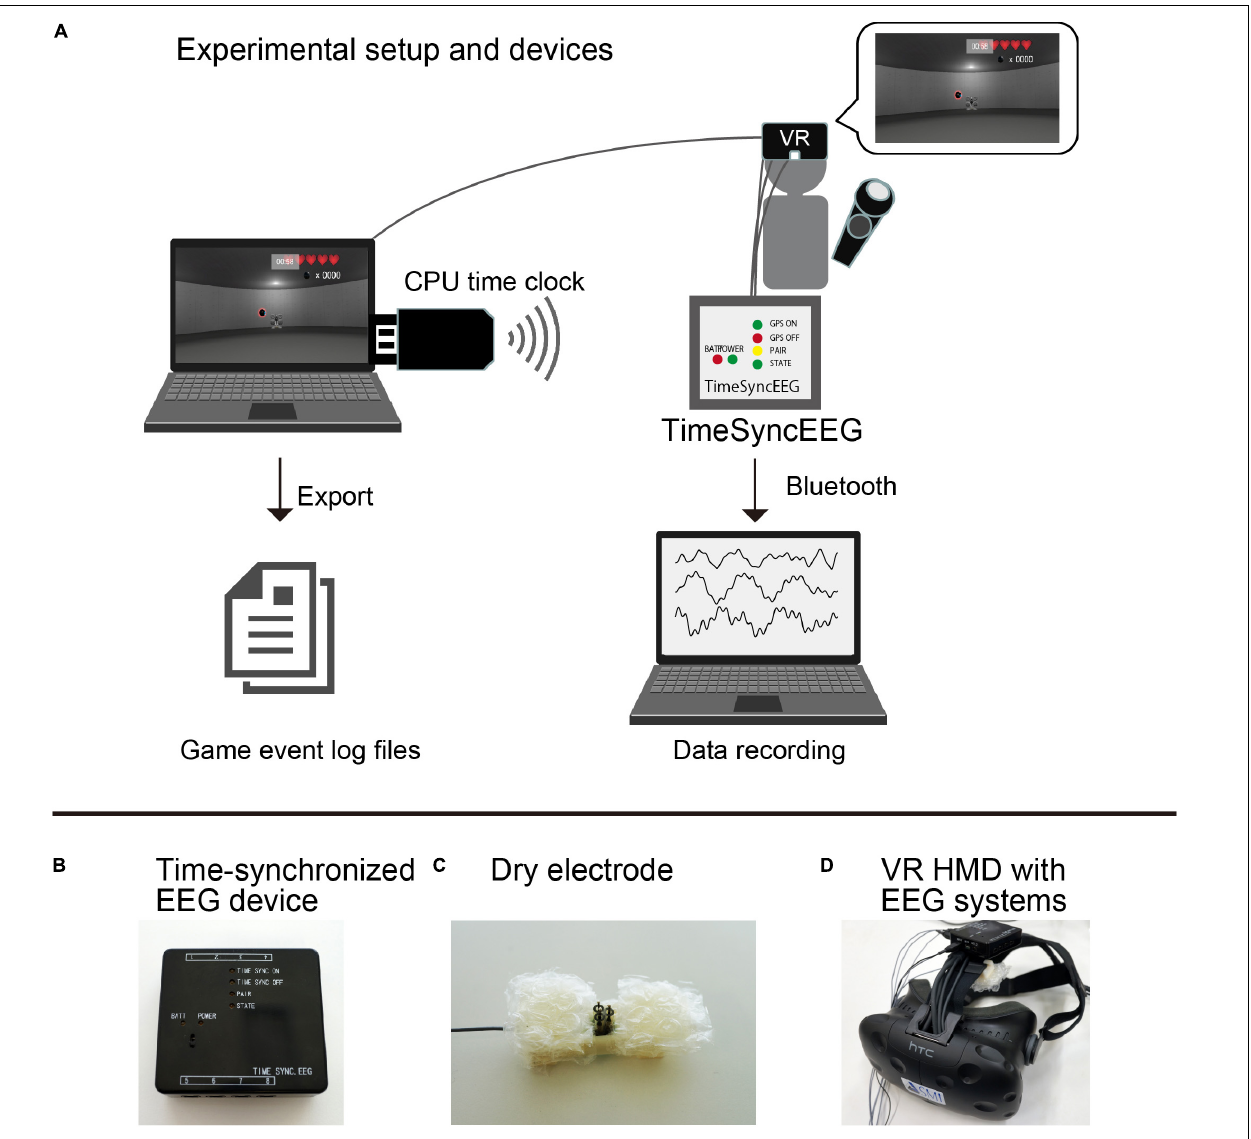
FIGURE 2 | (A) Experimental setup and devices. (B) Time-synchronized electroencephalogram (EEG) device. (C) Dry electrode. (D) Virtual reality (VR) head-mounted display with an EEG recording